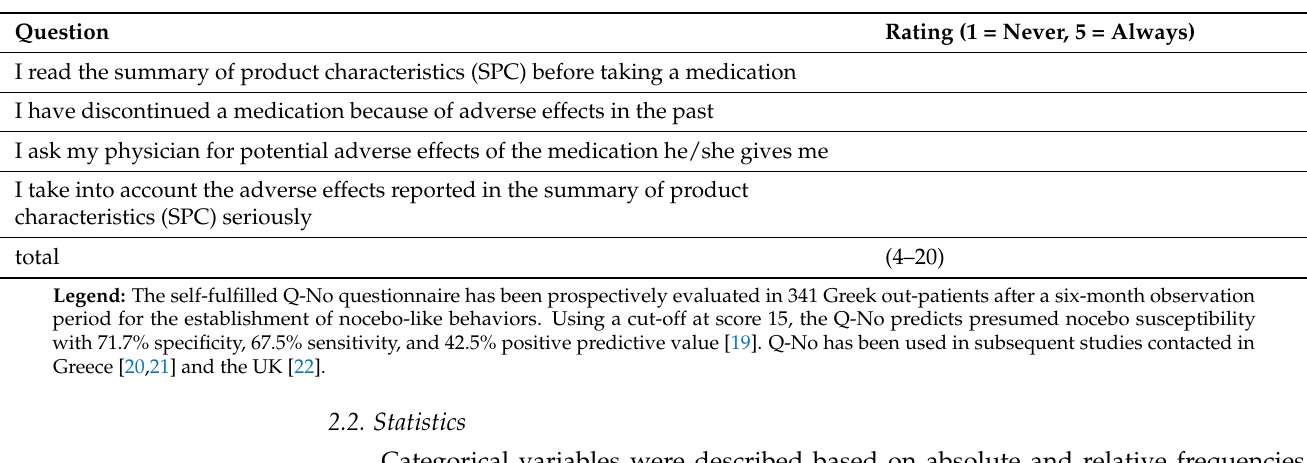
Table 1. The Q-No